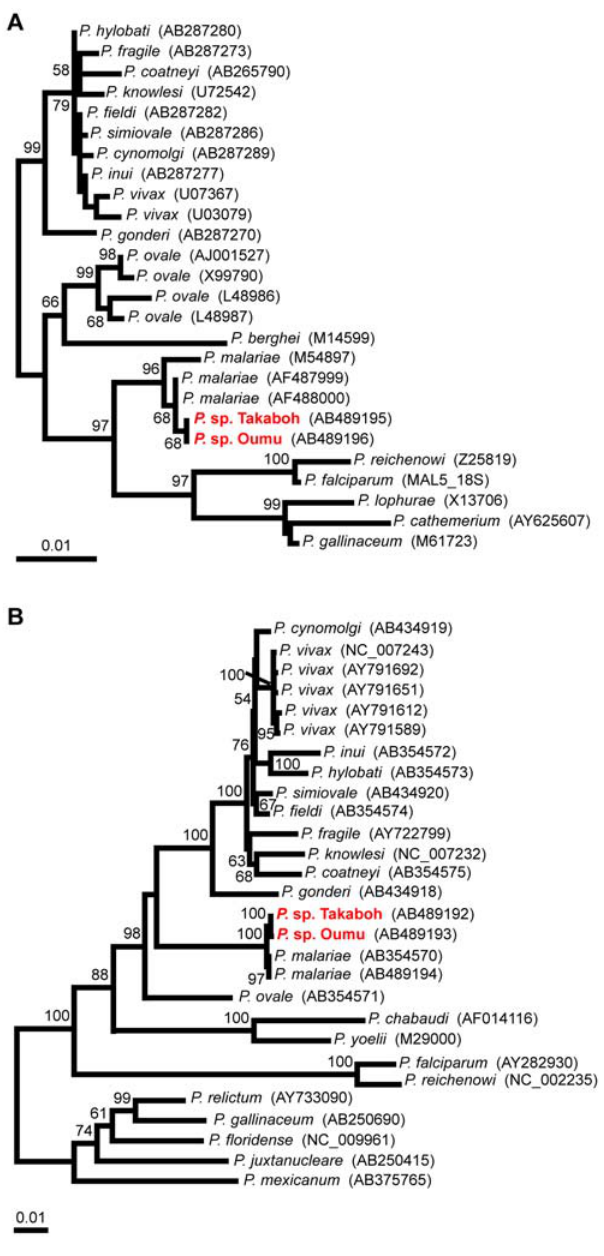
Figure 2. Phylogenetic trees of SSU rRNA gene (A) and mitochondrial genome (B). The numbers on the phylogenetic tree represent bootstrap values based on 1000 replications. GenBank accession numbers are in brackets.